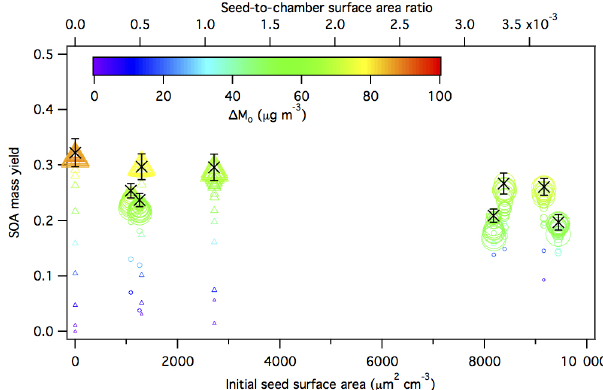
Figure 4. Averaged SOA mass yields over the course of an α -pinene ozonolysis experiment as a function of initial total AS seed aerosol surface area concentration. Results from this study (15min aver- aged) are shown as circles, while results from the study by Nah et al. (2016) (10min averaged) are shown as triangles. All the SOA mass yields shown here (including results from Nah et al., 2016) are obtained using the coagulation-corrected size-dependent particle- wall deposition coefficients. Symbol color indicates the SOA mass concentration and symbol size indicates the time after O 3 is injected into the chamber. The × symbols are the SOA mass yields at peak SOA growth obtained from the experimental data. The y axis er- ror bars represent the uncertainty in the SOA mass yield at peak SOA growth, which originates from the α -pinene injection and the aerosol mass concentration at peak SOA growth (1 standard devia-